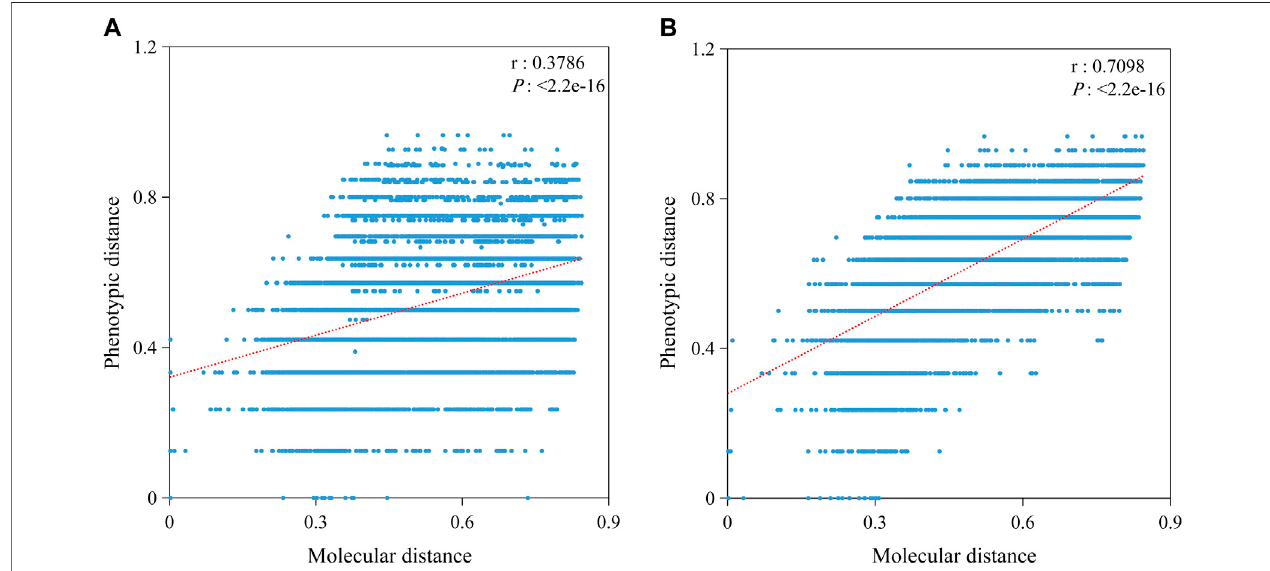
FIGURE 7 | Correlation between molecular and phenotypic distances in different groups. (A) Correlation based on 15 traits with predicted values less than 0.443. (B) Correlation based on 15 traits with predicted values more than 0.443. P is the signi fi cance level, and r is the correlation coef fi cient.